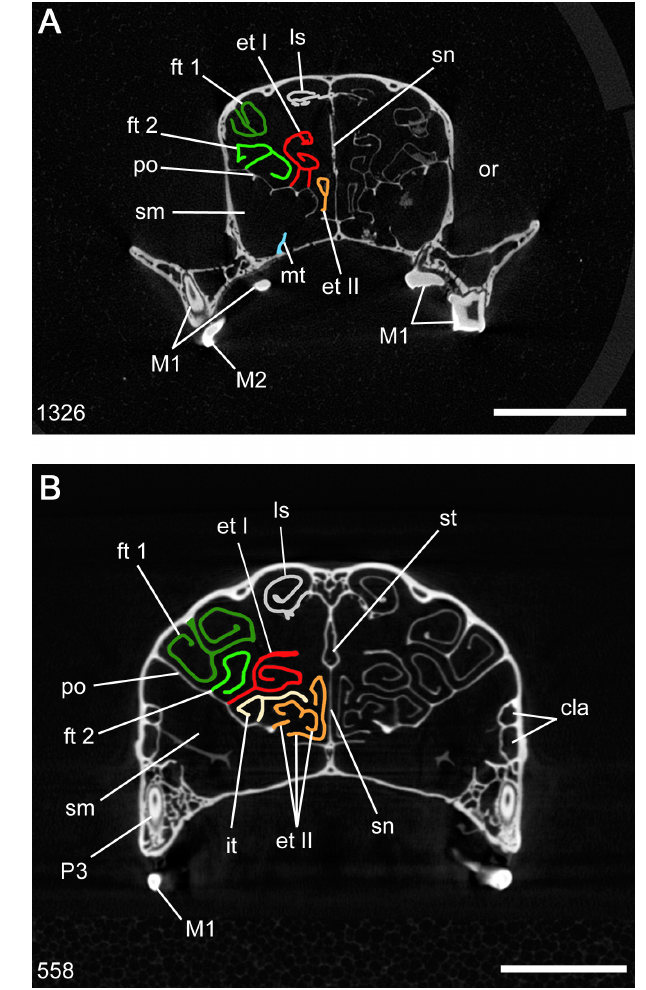
Figure 10. µCT cross-section images of the pars lateralis and pos- terior of the adult rostrum from anterior to posterior of (a) Ptilo- cercus lowii (ZMB 3992) and (b) Tupaia sp. (collection W. Maier). Numbers in figures refer to number of original µCT slices. Abbre- viations: cla, canaliculus lacrimalis; dnp, ductus nasopharyngeus; et I, II, III, ethmoturbinal I, II, III; fla, foramen lacrimale; ft 1, 2, frontoturbinal 1, 2; it, interturbinal; lc, lamina cribrosa; ls, lamina semicircularis; M1, 2, upper molar 1, 2; or, orbit; po, pars obtecta (paries conchalis); sm, sinus maxillaris; sn, septum nasi; st, septo- turbinal. Scale bars equal